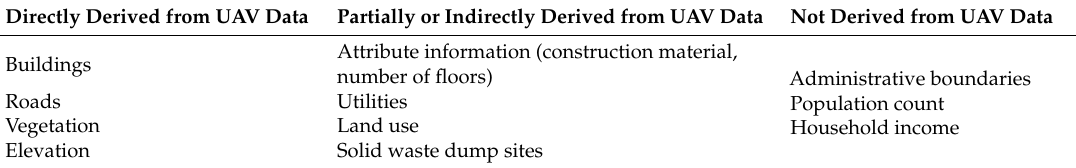
Table 1. Examples of geospatial information derivable from UAV